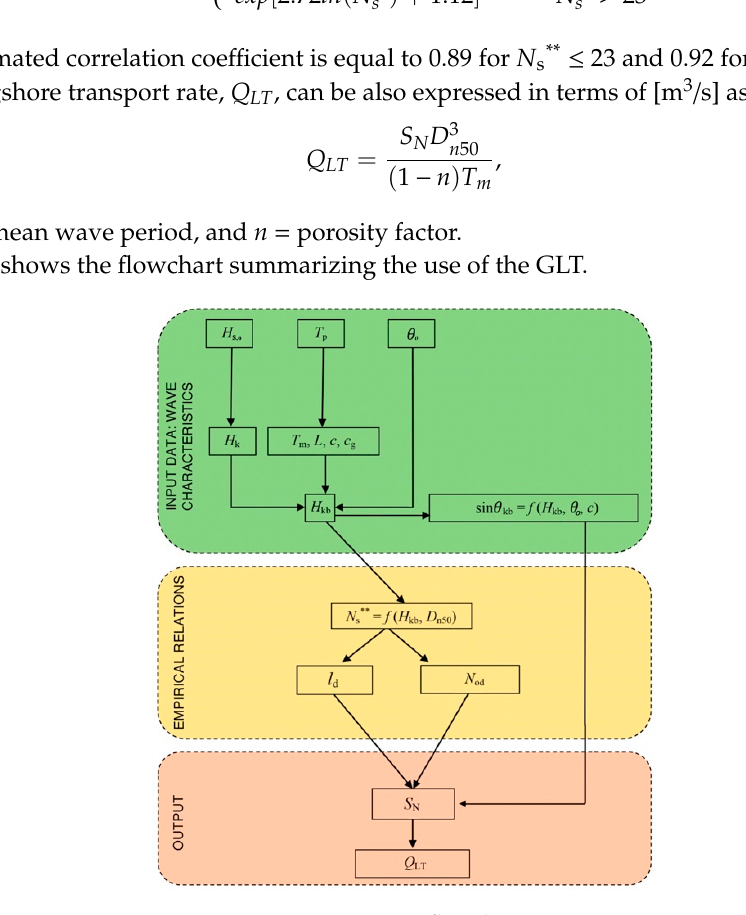
Figure 2. User flowchart.